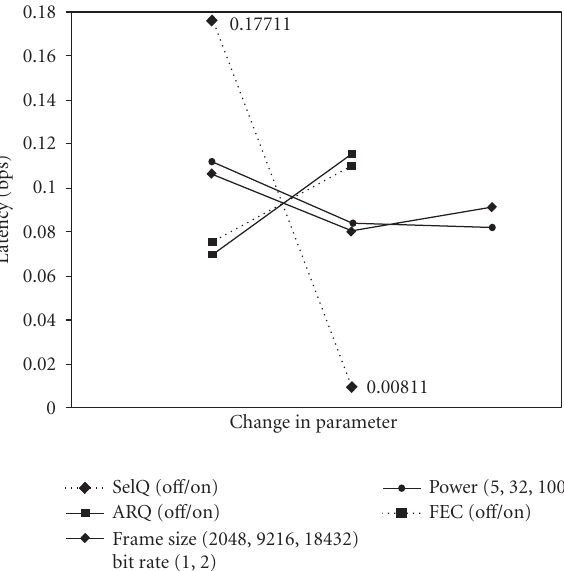
Figure 12: VoIP latency versus average e ff ect of a parameter.